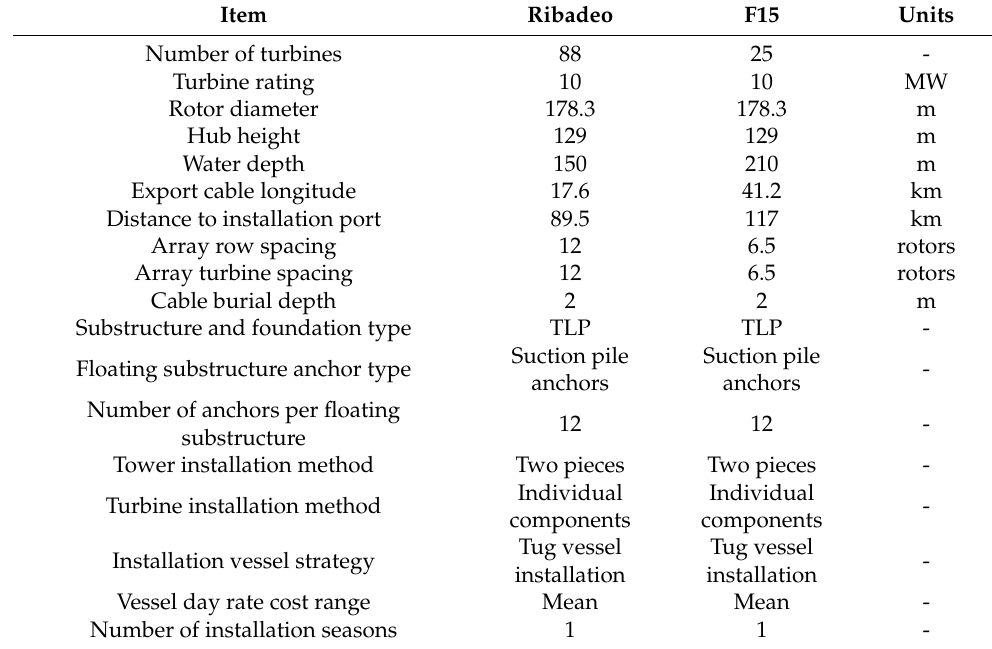
Table 3. General data and